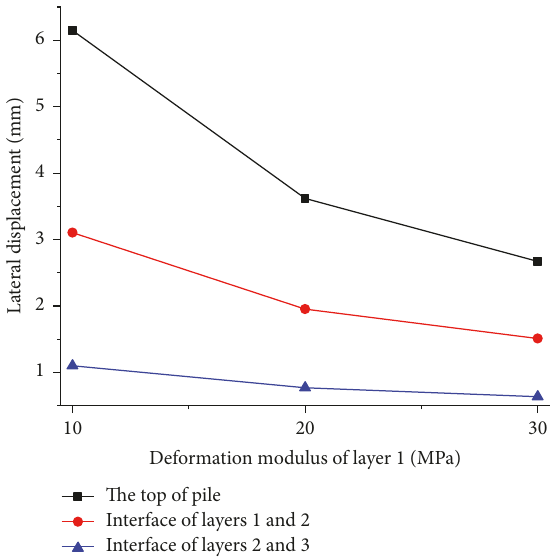
Figure 4: Relationship between lateral displacement of pile and stacking loads.